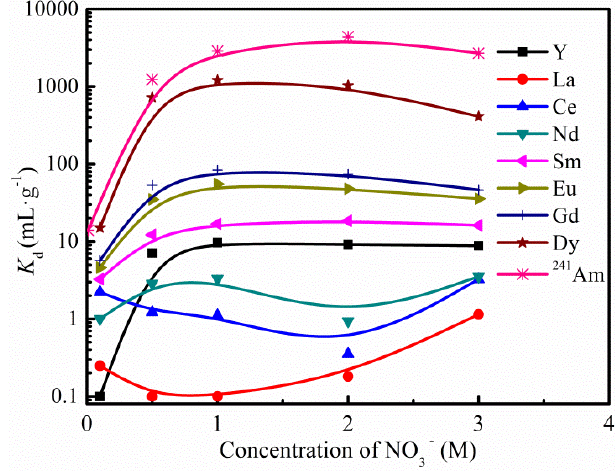
Figure 4. Relationship of adsorbability of 241 Am(III) and Ln(III) towards iso Bu-BTP/SiO 2 -P with the nitrate concentration (NaNO 3 , pH 2, 298 K, 24 h).